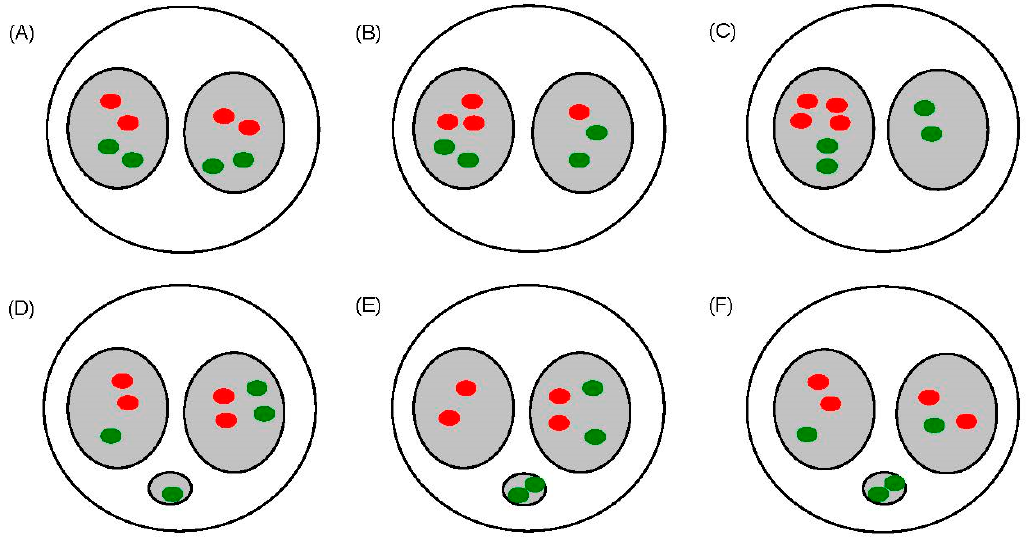
Figure 2. Schematic of FISH signals to demonstrate aneuploidy of chromosomes 1 (red) and 4 (green). ( A ) Normal cell with two signals in each daughter nucleus. ( B , C ) Aneuploidy induced by non-disjunction. No signal was observed in micronuclei; this includes 3 + 1 (three signals in one daughter nucleus and one signal in another daughter nucleus) and 4 + 0 (four signals in one daughter nucleus only). ( D – F ) Aneuploidy induced by chromosome loss. Signal(s) was/were observed in micronuclei; this includes 2 +1 + 1 two signals in one daughter nucleus and one signal in another daughter nucleus plus a micronucleus with a positive signal), 2 + 0 + 2 (two signals in one daughter nucleus plus micronucleus with two positive signals) and 1 + 1 + 2 (signal in each daughter nucleus plus micronucleus with two positive signals). Table 2. The frequency of different types of aneuploidy in chromosome 1 from X-irradiated fibroblasts. Time after Irradiation (h) Dose